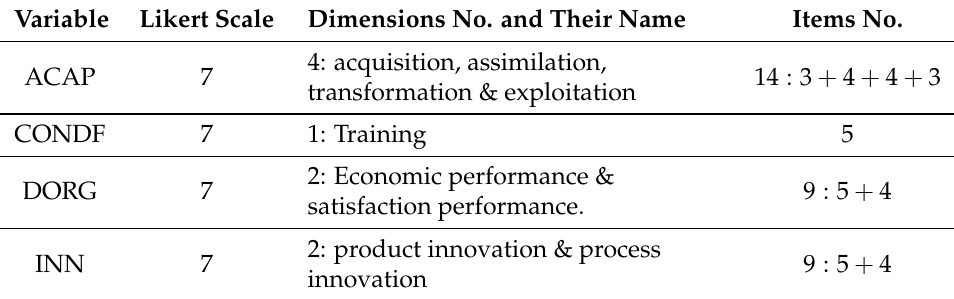
Table 10. Information of the variables used in [49].